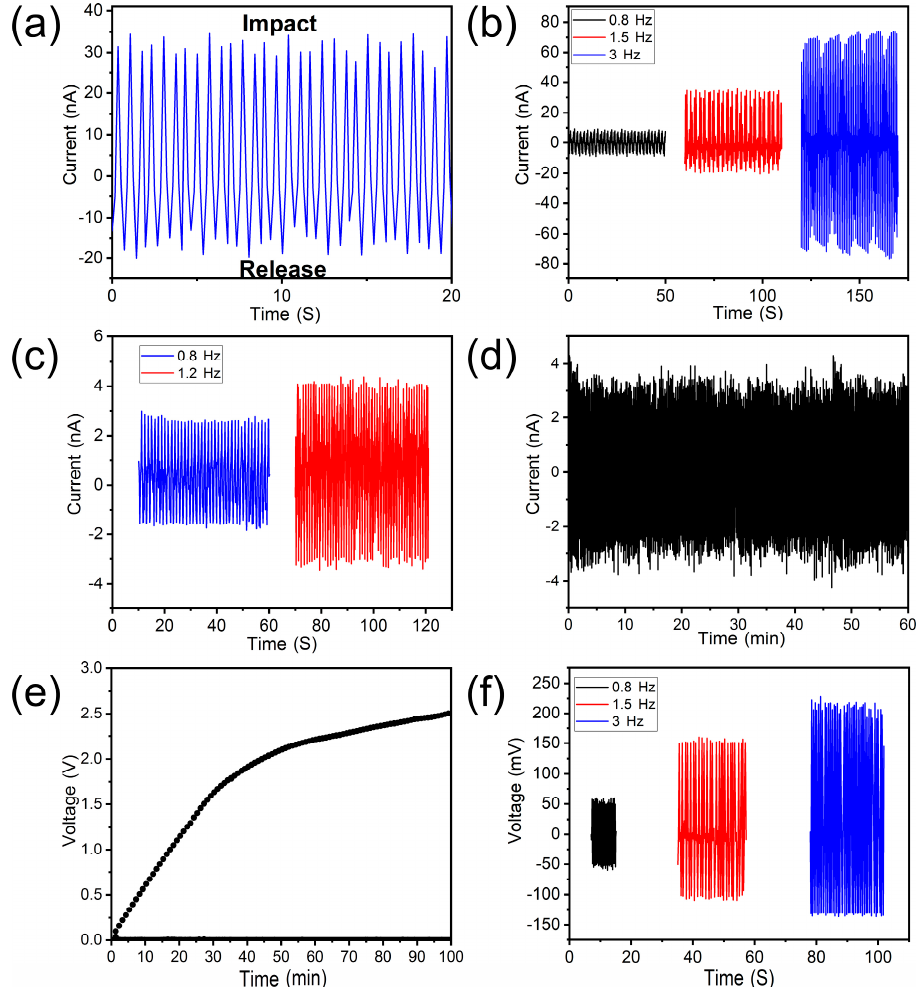
Figure 5. ( a ) Output current of the SBS PVDF non-woven under 1.5 Hz repeated compressive impacts. ( b ) Influence of compression frequency on the output current of the nanogenerator. ( c ) Influence of mechanical bending on the output current of the nanogenerator. ( d ) The durability test results of the nanogenerator subjected to a bending frequency of 1.2 Hz. ( e ) The voltage of the 47 µ F capacitor versus charging time for the nanogenerator to be operated under 0.8 Hz bend frequency. ( f ) Influence of compression frequency on the output voltage of the